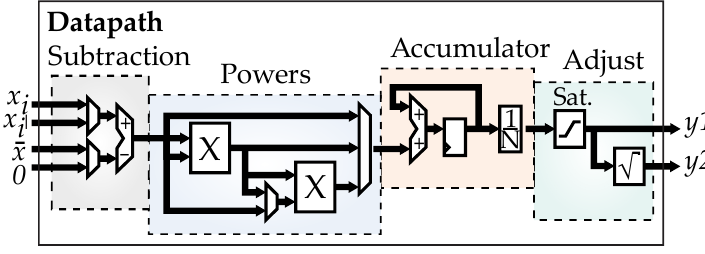
Figure 2. General hardware architecture of the datapath IPcore.